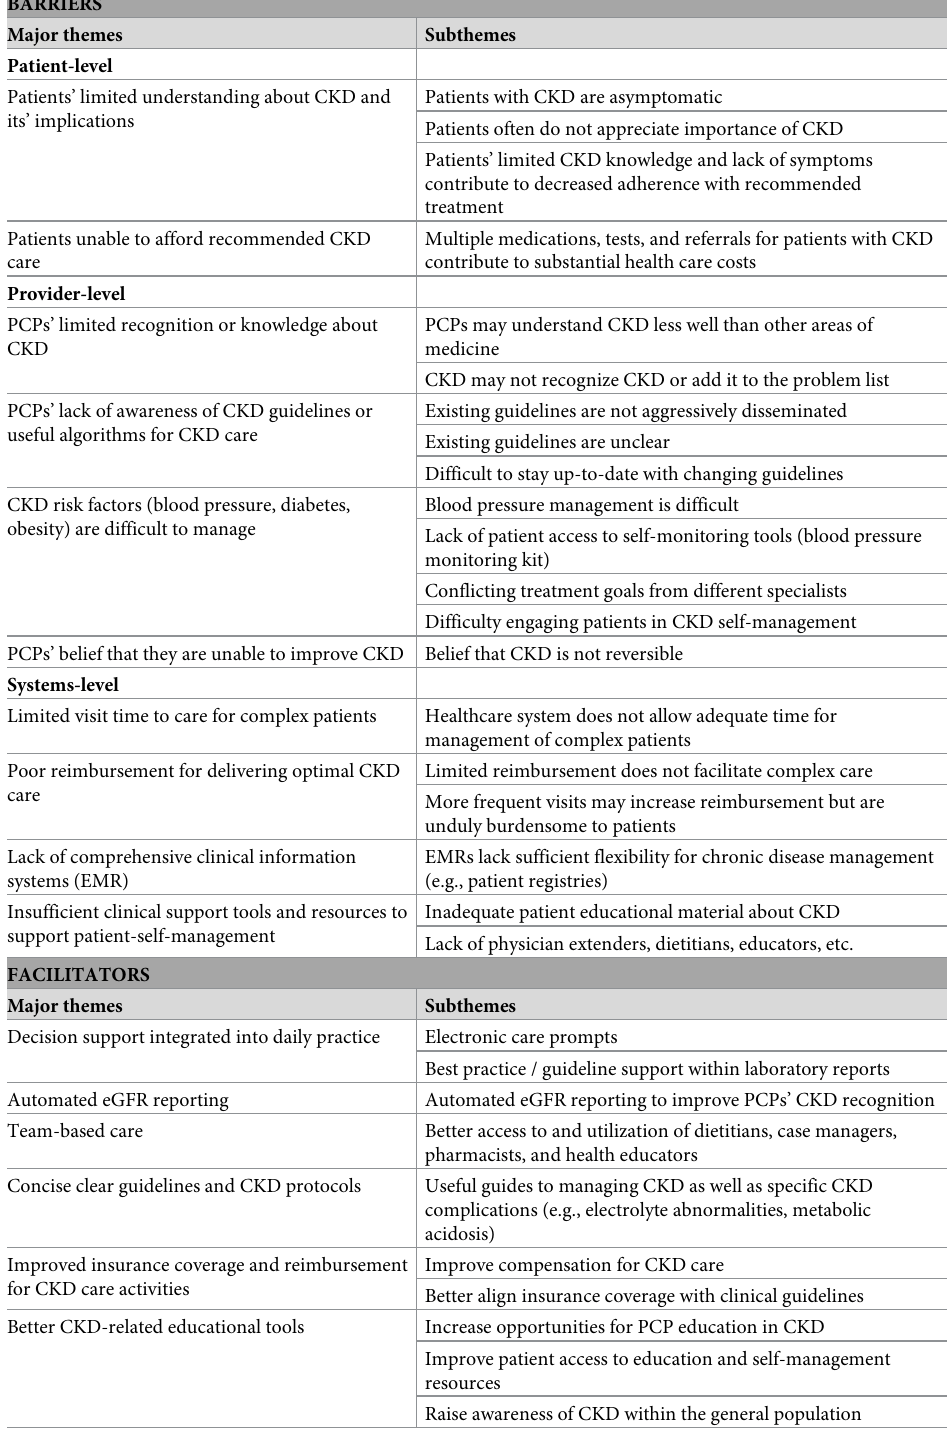
Table 3. Primary care physicians’ perceived barriers and facilitators to CKD